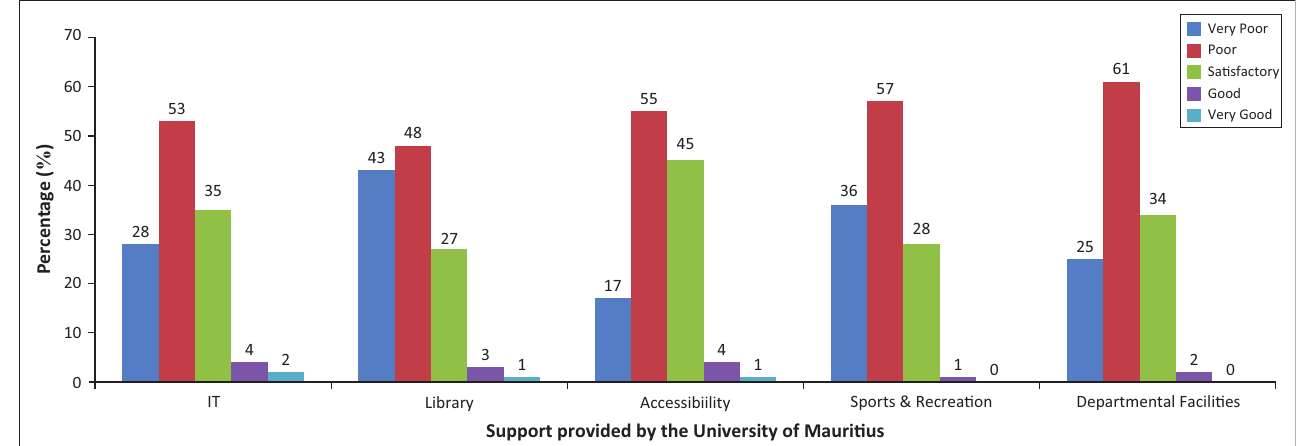
FIGURE 4: Provision for students with